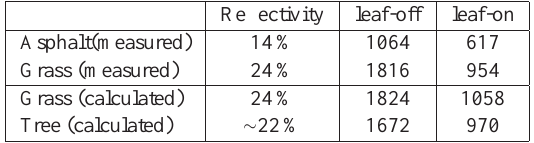
Figure 11: Histogram of the integrals of waveforms returned from asphalt respectivly grass for both data sets